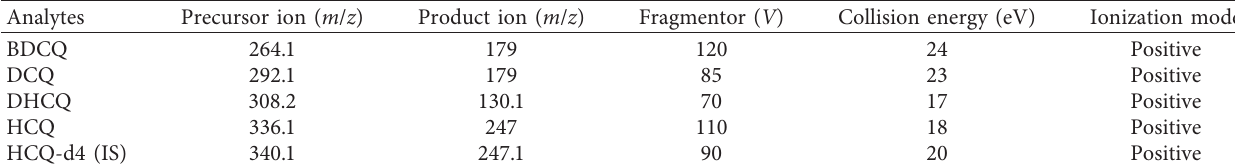
Table 1: Optimized MRM parameters for the detection of four analytes and